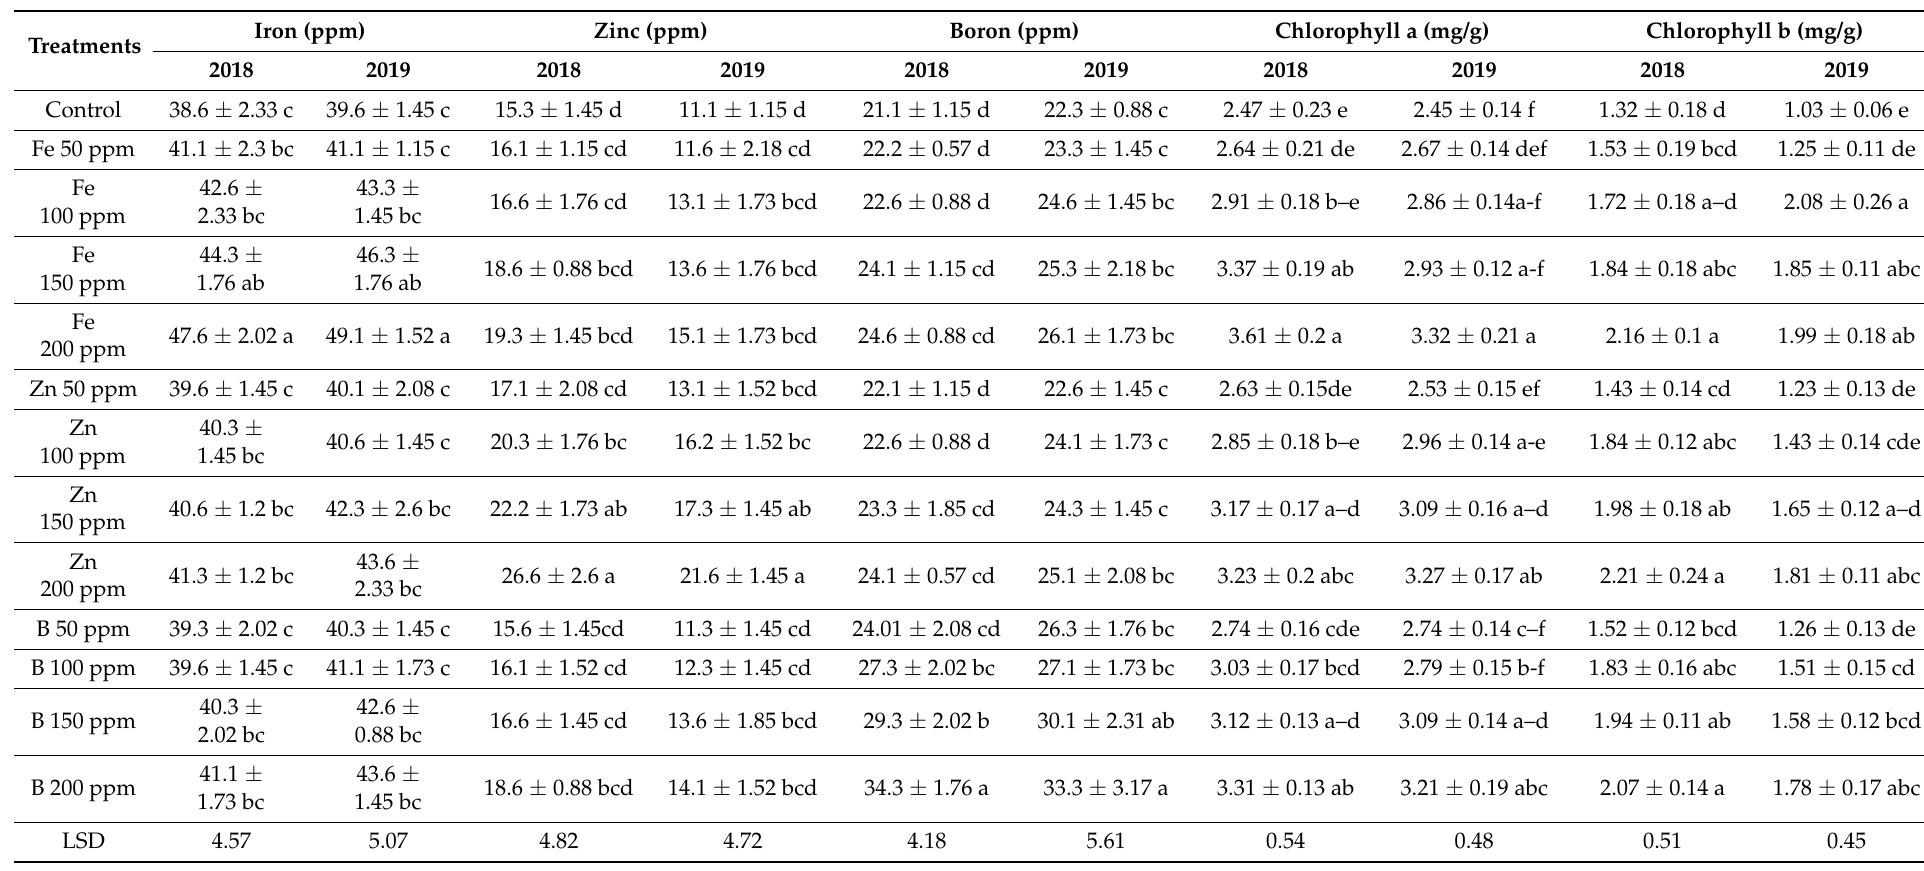
Table 5. Effect of foliar application of micronutrients on leaf mineral and chlorophyll concentration of grapes cv. ‘Flame Seedless’ during the years 2018 and 2019.